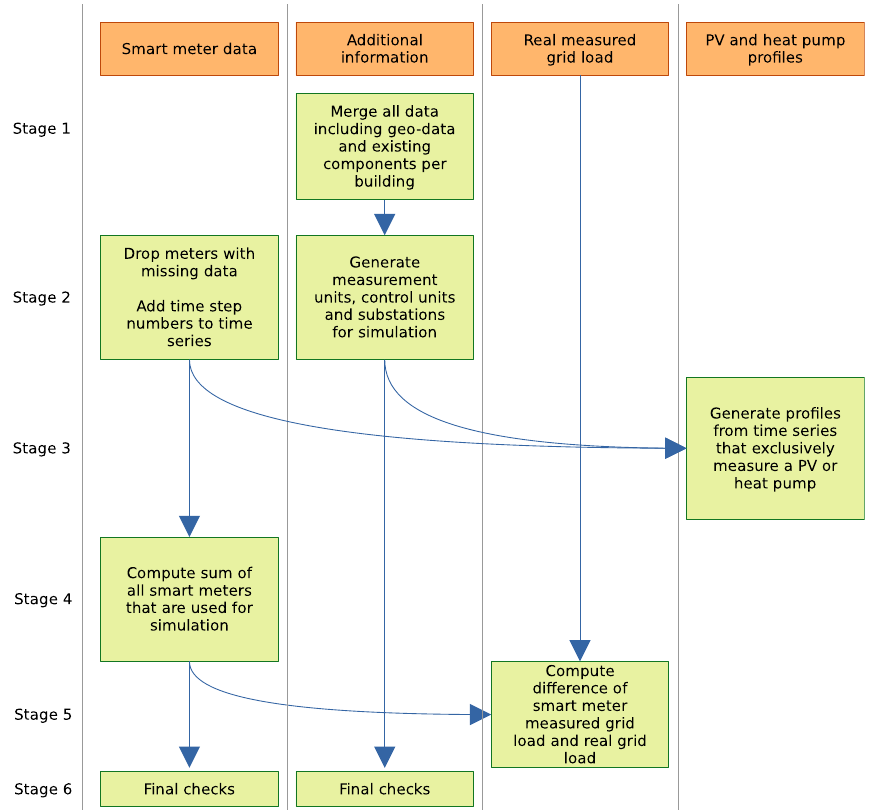
Fig. 7 Overview of the preprocessing pipeline. The orange boxes in the top line depict the different classes of input or output data - i.e., smart meter data from residential households, additional information about addresses, connected components, roof areas etc. of these households, the real measured grid load and PV or heat pump profiles. Green boxes represent processing